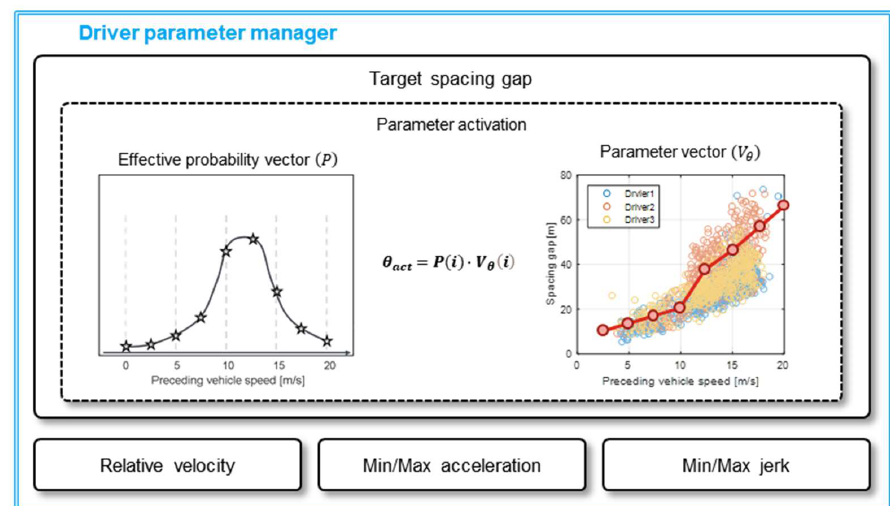
Figure 7. Parameter activation of driver parameter manager.